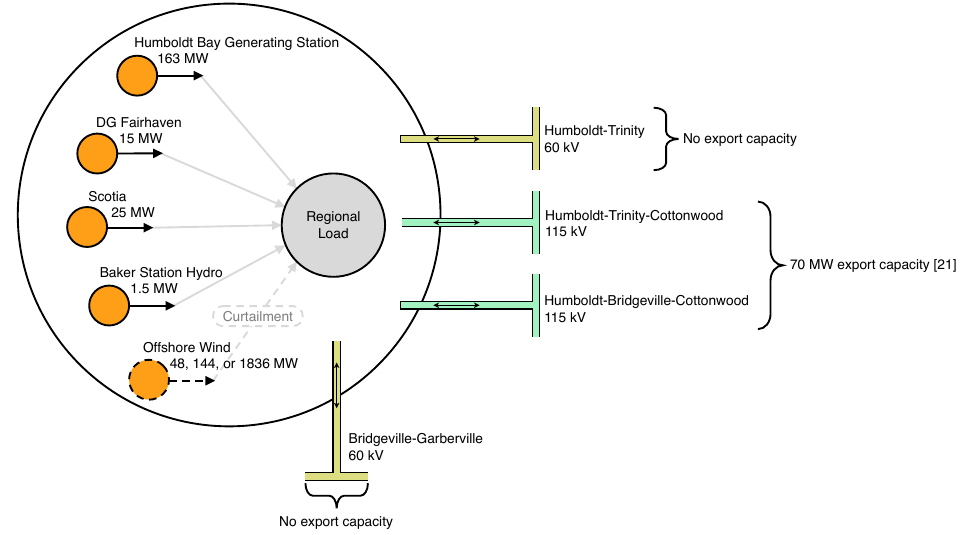
Figure 1. Humboldt County electrical system showing node inputs and